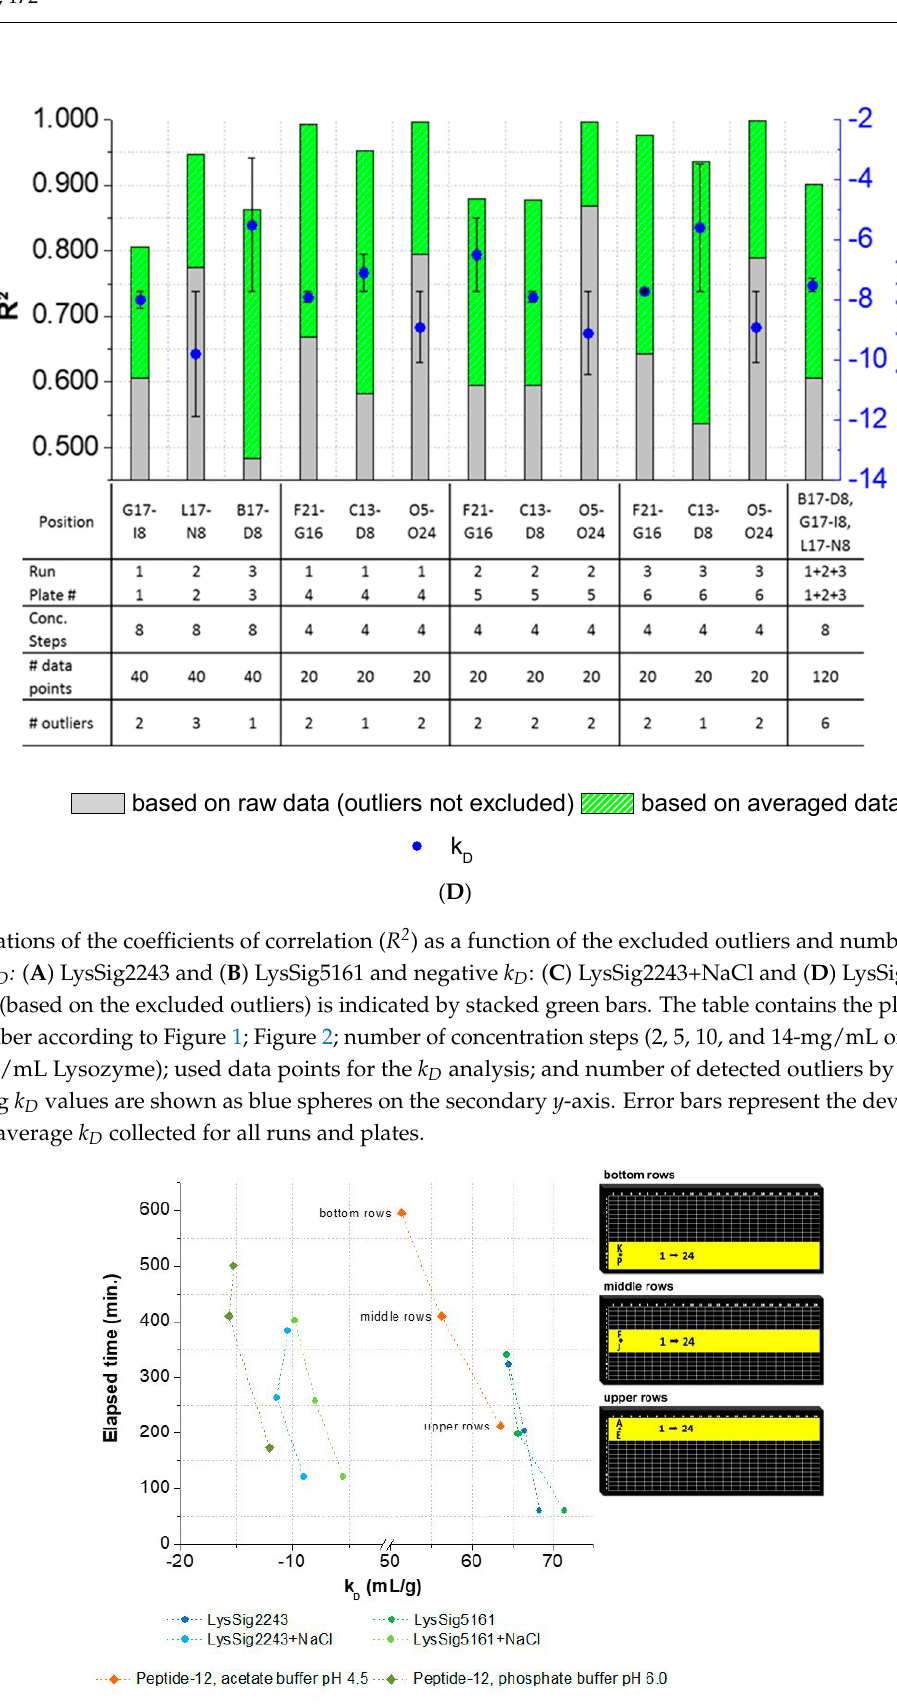
Figure 5. k D as a function of elapsed time and the corresponding plate positions (bottom, middle, and upper rows). Spheres present k D collected for lysozyme, and squares show k D collected for peptide-12 in acetate, pH 4.5 (orange), or phosphate, pH 6.0 (olive green), buffer. k D was calculated using the wells as highlighted in yellow on the right-hand side. Exact well numbers can be found in Appendix